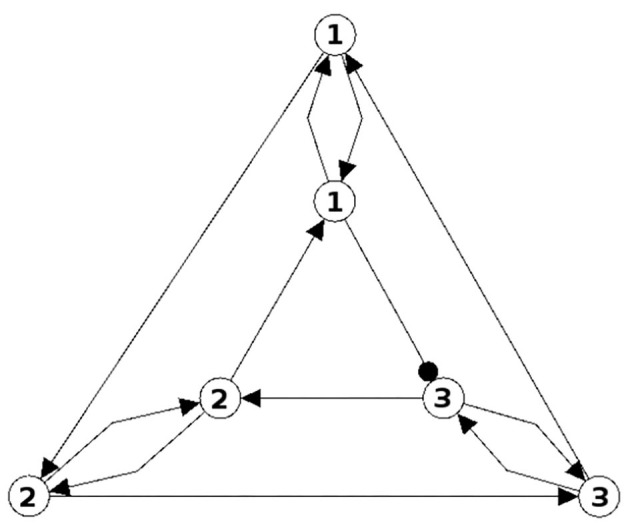
A six-neuron module which is not s-decomposable into two three-neuron modules. It is a basic module.